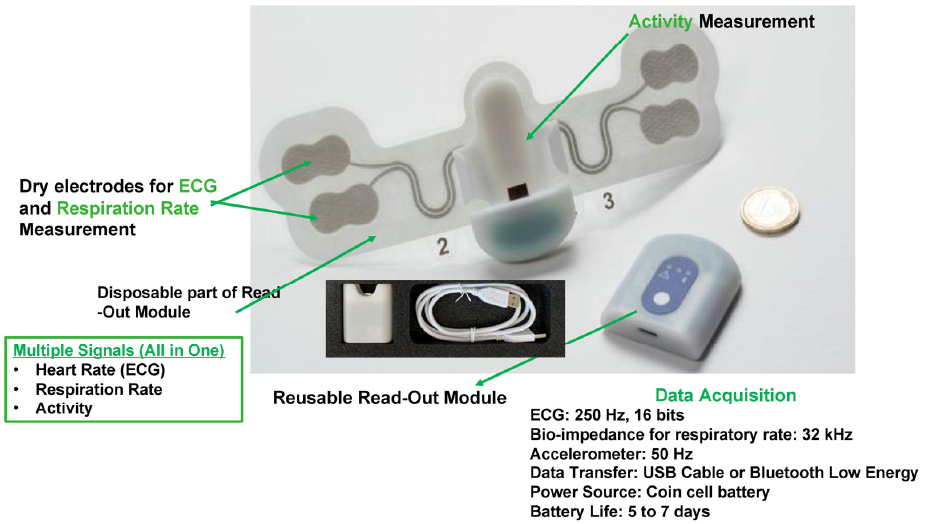
Figure 2. Photo of the Portable 3-in-1 Sensor Patch. Source: TNO Holst Centre, Eindhoven, The Netherlands.